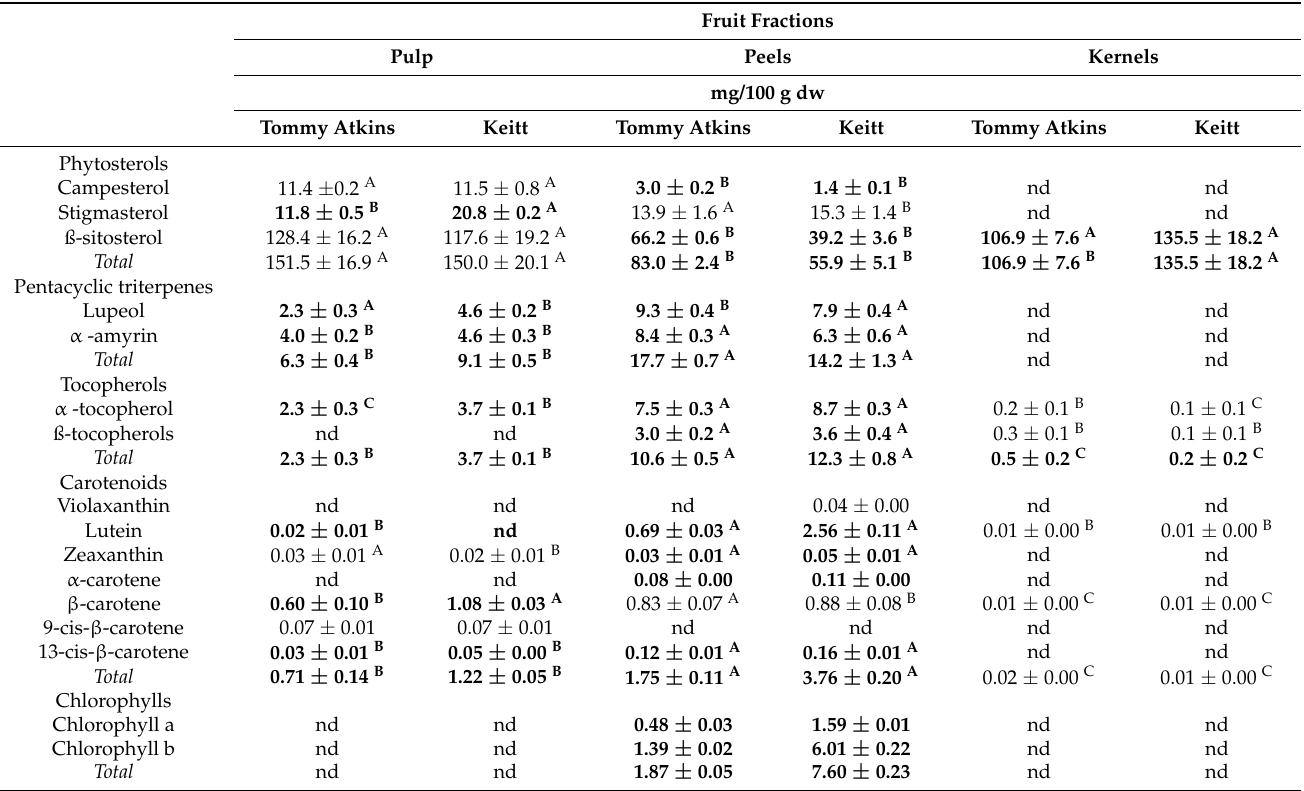
Table 2. Quali-quantitative evaluation of the main lipophilic phytochemicals (phytosterols, penta- cyclic triterpenes, tocopherols, carotenoids and chlorophylls) in the pulp, peels and kernels of ripe mango fruits of the cultivars Tommy Atkins and Keitt. Fruit